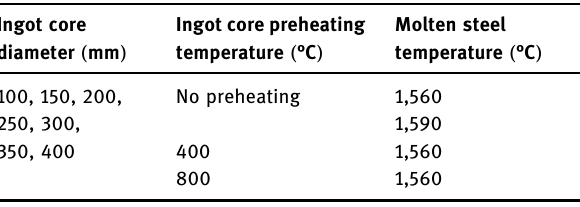
Table 3: Numerical simulation scheme